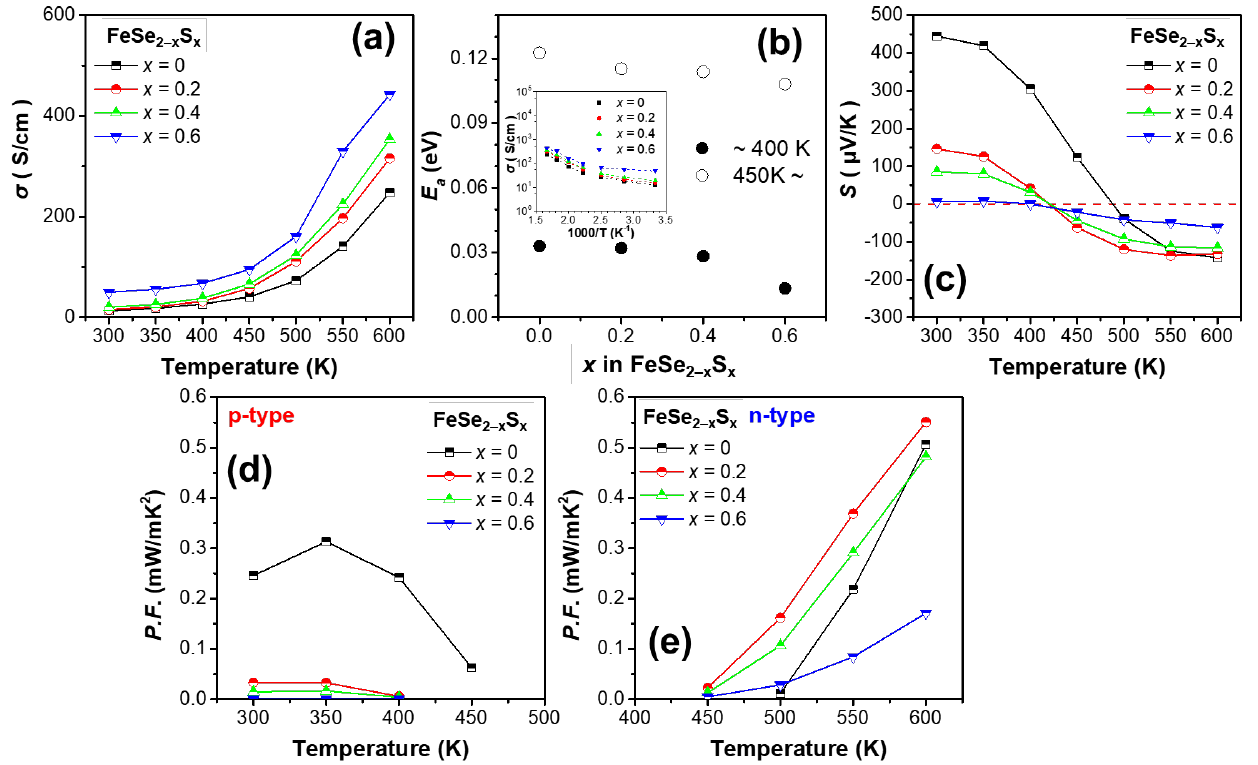
Figure 2. ( a ) σ as a function of the temperature for the series of FeSe 2− x S x ( x = 0, 0.2, 0.4, 0.6, and 0.8) samples. ( b ) E a of the samples calculated from σ for 300 – 400 K and 450 – 600 K. The inset of ( b ) shows logarithmic σ as a function of 1000/ T for the samples. ( c ) S as a function of temperature for the samples. Power factors as functions of temperature for the samples in ( d ) p - and ( e ) n -type regions.